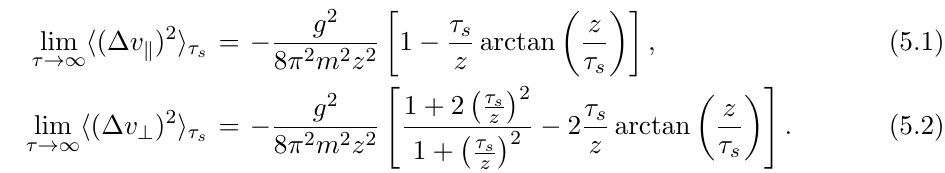
( t ) is implemented and the s ;(cid:28) ) or perpendicular ( k ?